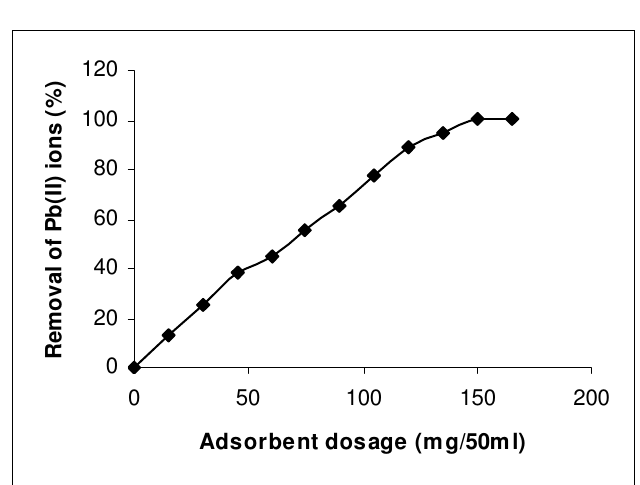
Figure 6 . Desorption of Pb(II) ions from SCH carbon